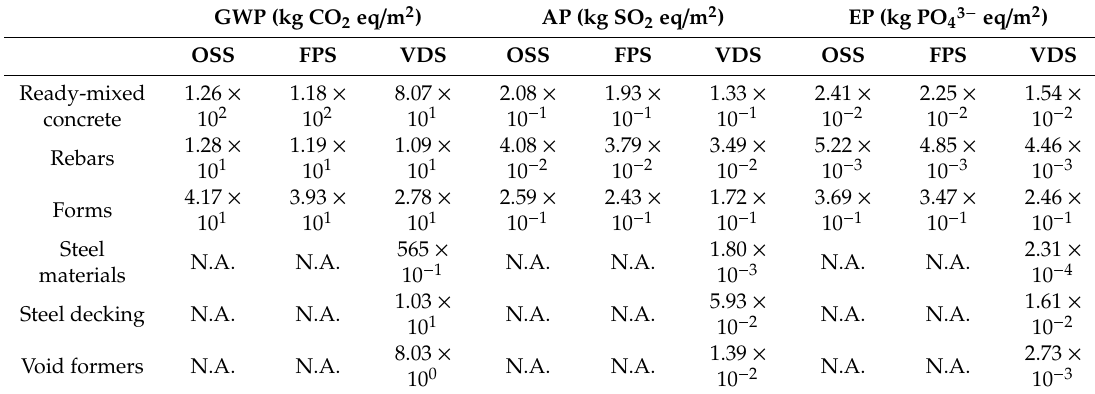
Table 6. The environmental impact of building materials.